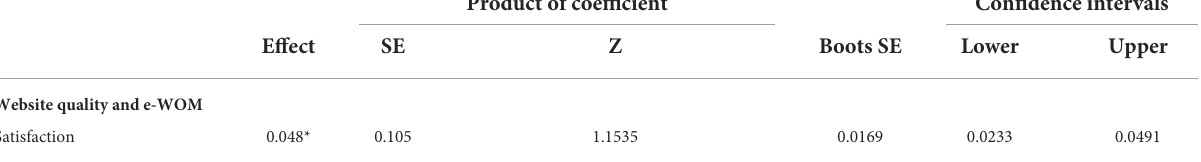
TABLE 8 Results of bootstrap